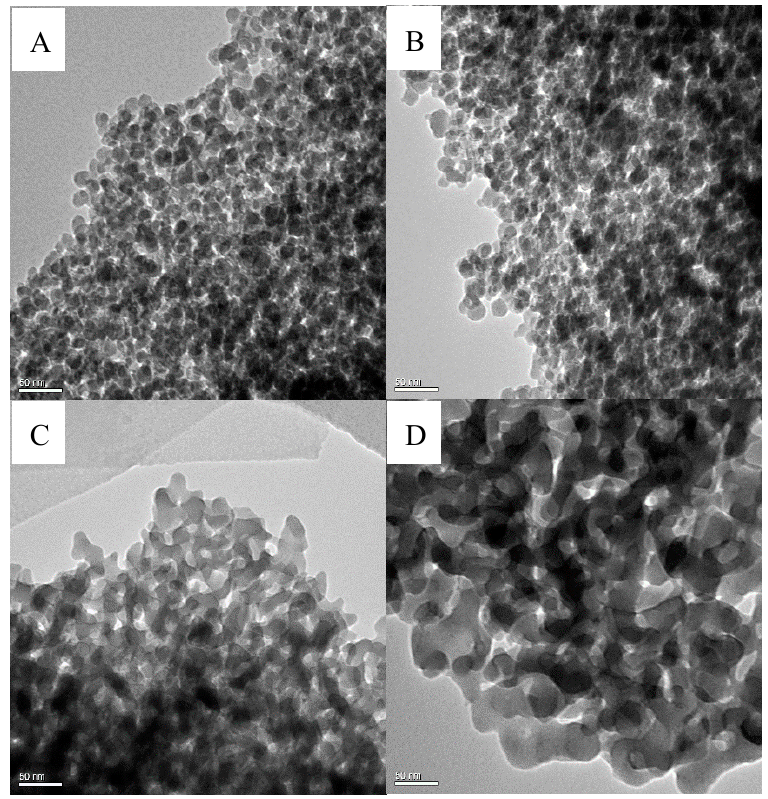
Figure 2. TEM images of prepared catalysts: ( A ) Ni / Si-Al (25, RT); ( B ) Ni / Si-Al (25, 80); ( C ) Ni / Si-Al (15.2, RT); ( D ) Ni / Si-Al (7.7, RT).